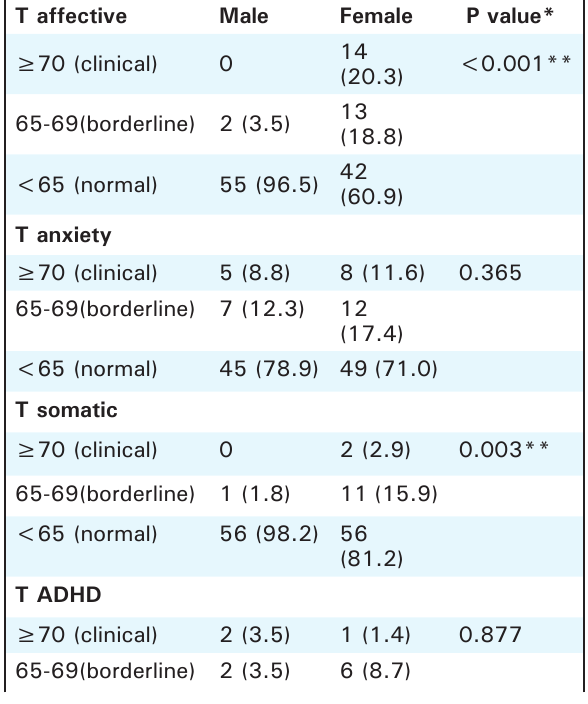
Table 3. T score categories according to gender n (%).